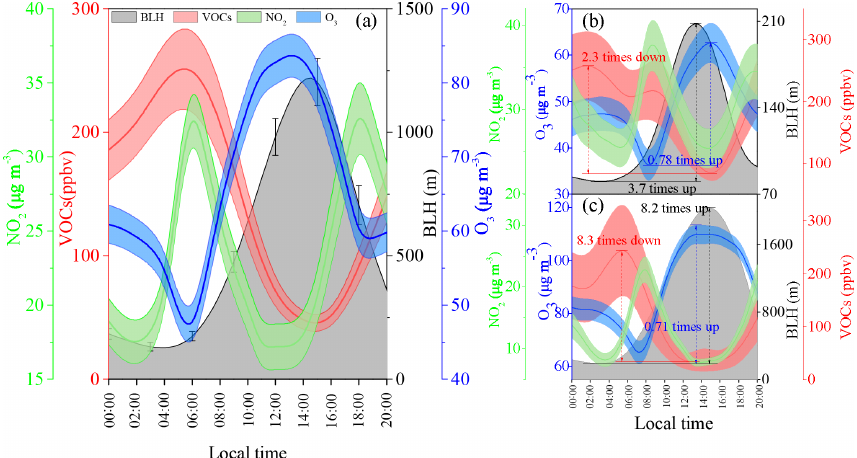
Figure 7. Diurnal variation in boundary layer height (BLH), VOC, NO 2 , and O 3 concentrations on different timescales: annual (a) , winter (b) and summer (c) . The solid line represents the average value and the filled area indicates the 95th confidence intervals of the